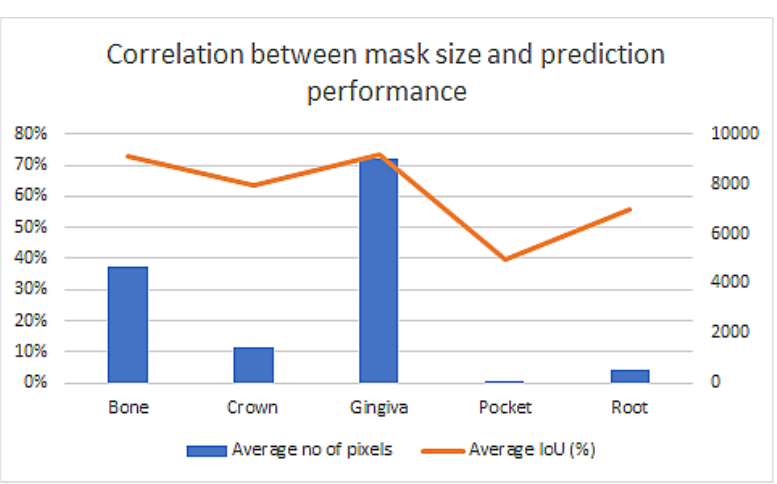
Figure 16. The correlation between the element size (in pixels) and the prediction accuracy. Figure 17 shows that the prediction accuracy strongly correlates with the number of elements present in the